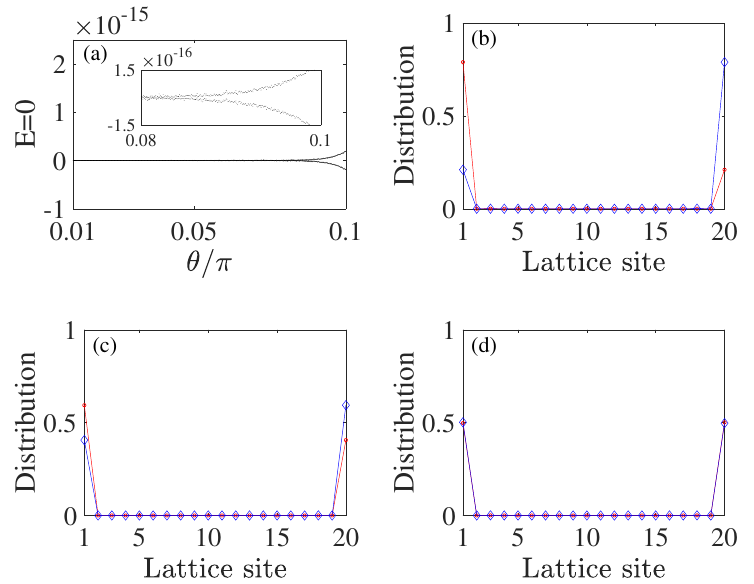
Figure 8. The two zero energy eigenvalues and their distributions. ( a ) The two zero energy eigenval- ues versus the parameter θ . The inset figure illustrates the detailed pattern for the splitting of the zero energy modes. ( b – d ) The distributions of two edge states when θ = 0.089 π in ( b ), θ = 0.095 π in ( c ), and θ = 0.12 π in ( d ). The red circle line represents the left edge state and the blue diamond line represents the right edge state. Other parameter takes N =